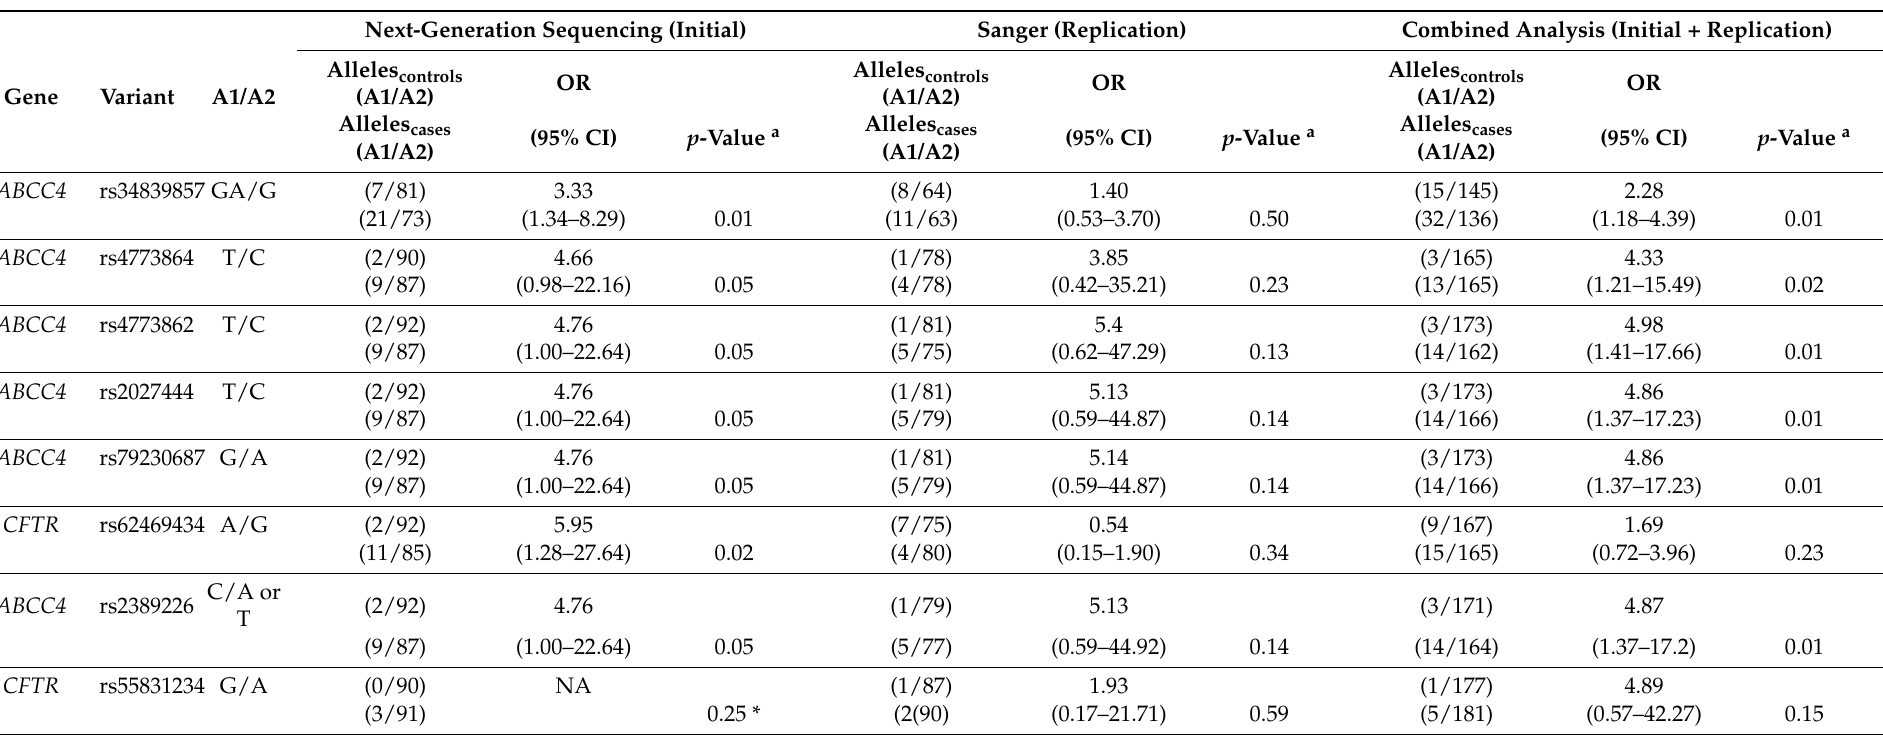
Table 4. Top ABCC4 and CFTR SNVs associated with AP identified through next-generation sequencing and replication analysis by Sanger